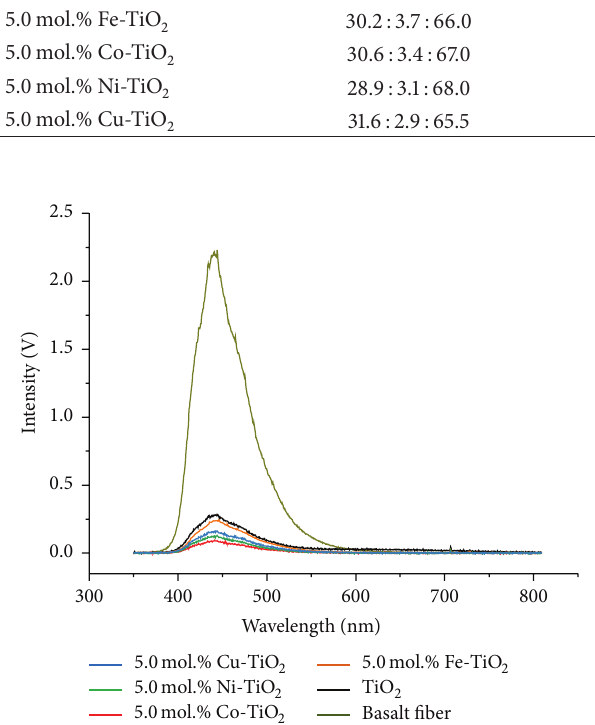
suggests that the electrons in the valence band are transferred to the conduction band and are stabilized by